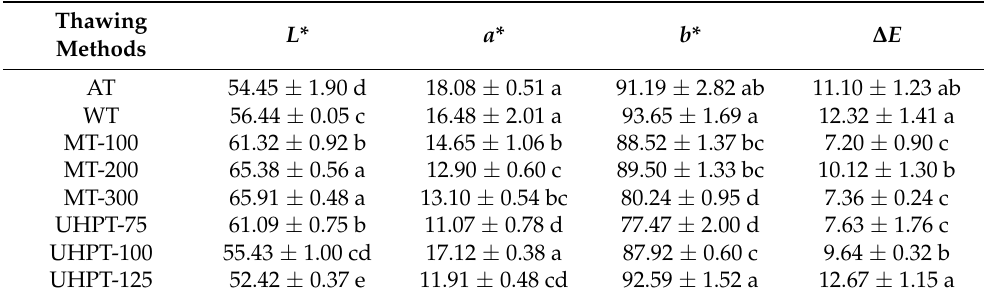
Table 2. The L *, a *, b * values and total color difference of fresh and thawed mangoes were affected by different thawing conditions. Thawing Methods